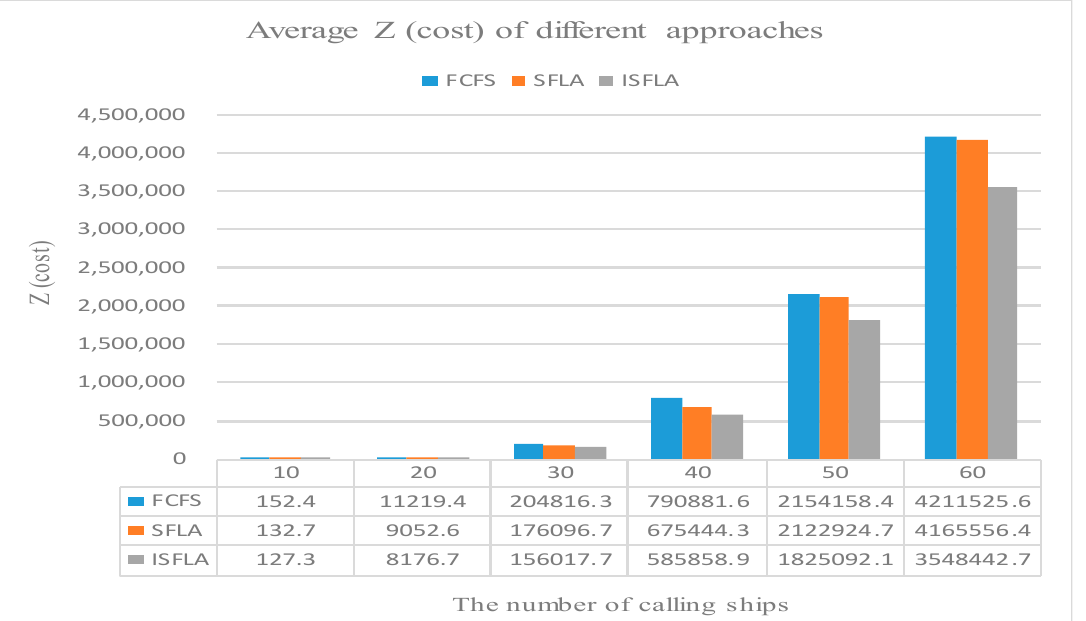
Figure 15. The average Z (cost) of different approaches under different coming ships.